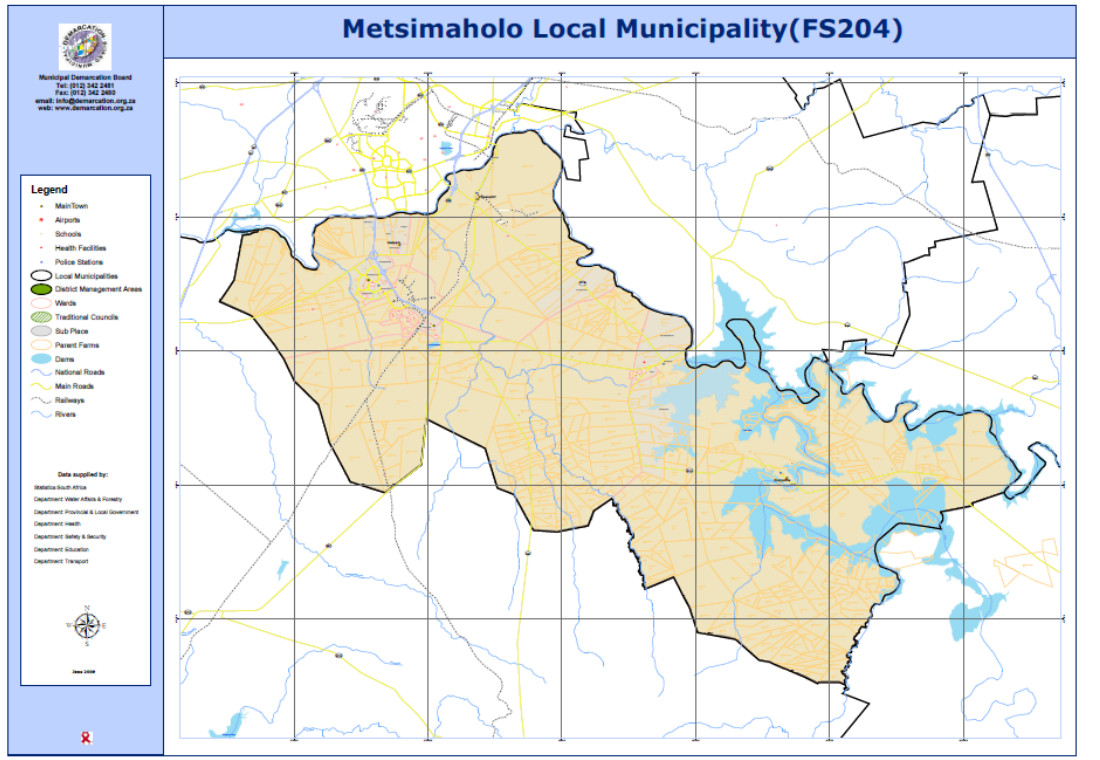
Figure 3 Boundaries of the Metsimaholo local municipality (Source: Municipal Demarcation Board http://www.demarcation.org.za